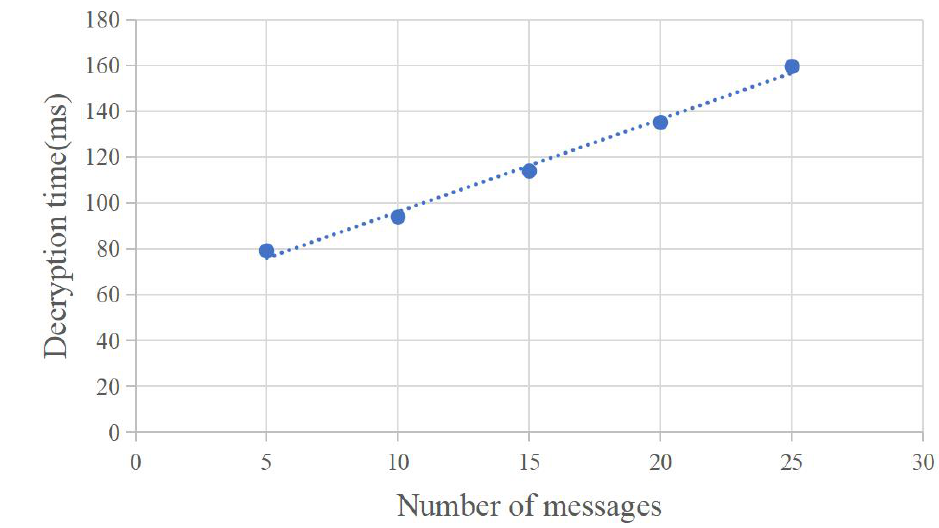
Figure 4. Decryption time according to